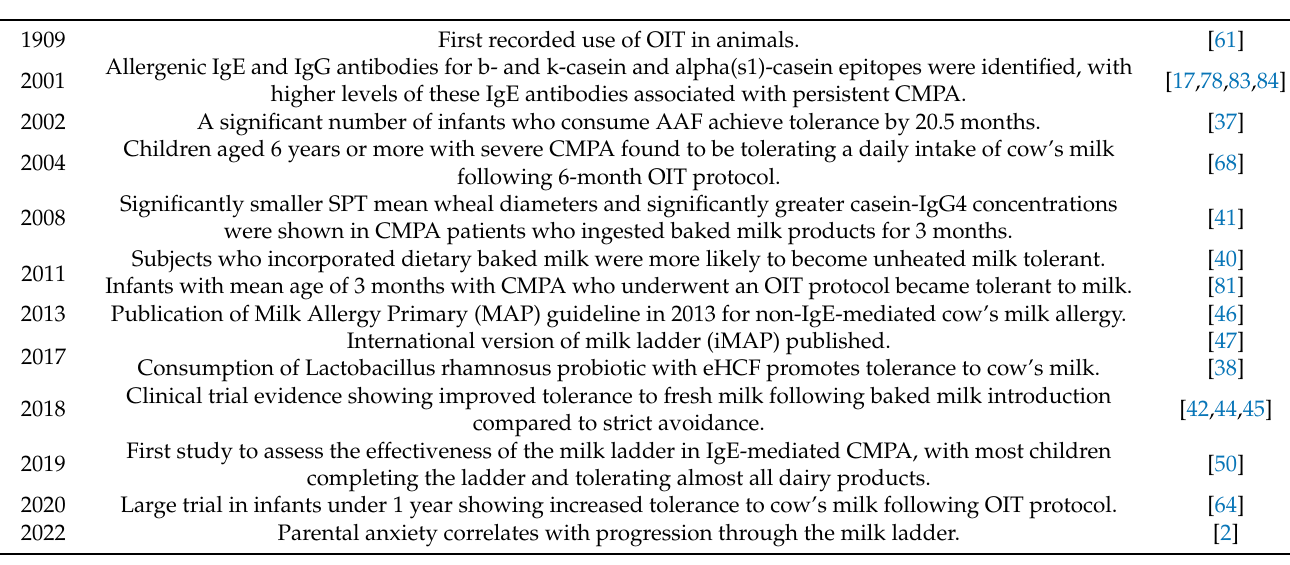
Table 6. Milestones of the development of treatment of CMPA.